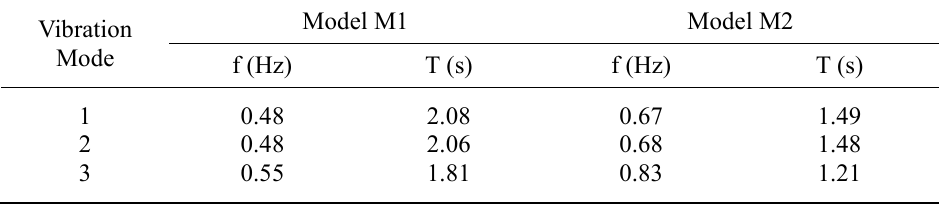
Fig. 6. Vibration modes of the building: Models M1 e M2. Natural frequencies (f) and periods (T) of the FEM M1 and M2. Vibration